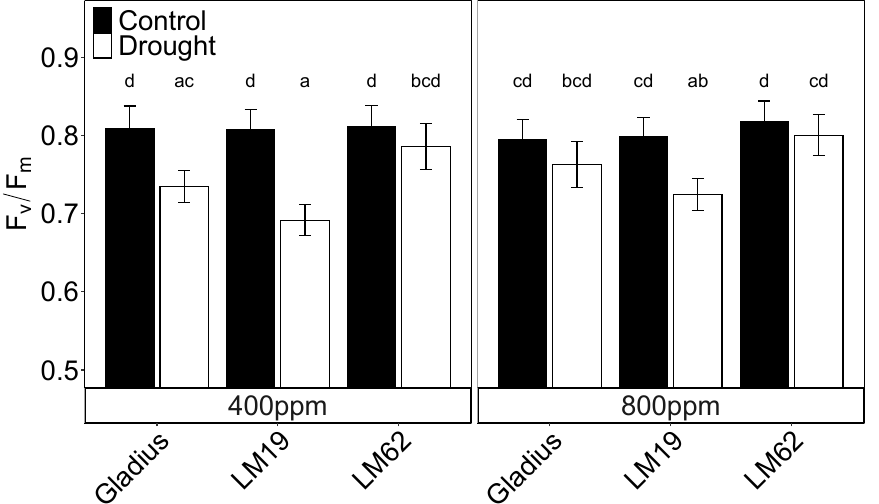
Figure 4. Maximum quantum efficiency of photosystem II (Fv/Fm) of the flag leaf of three spring wheat genotypes (Gladius, LM19 and LM62) under well-watered conditions (Control, black bars) or affected by drought (Drought, white bars) at aCO 2 (400 ppm) and eCO 2 (800 ppm). The measurements were conducted with a PAM-2500 on each genotype at the end of the treatment period. Values are mean ± SE ( n = 8–16). Values that share a letter are not significantly different according to Tukey’s honestly significant test ( p < 0.05).